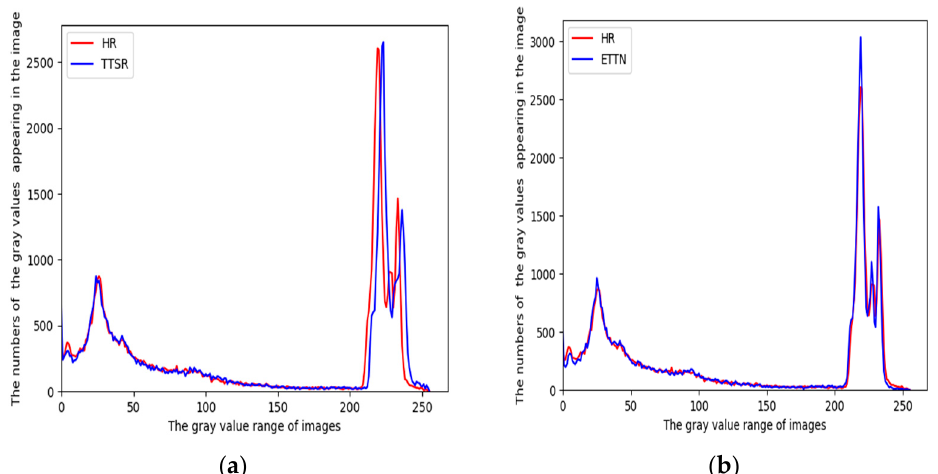
Figure 6. Histograms of the model images. ( a ) HR images of the TTSR model; ( b ) HR images of our model.